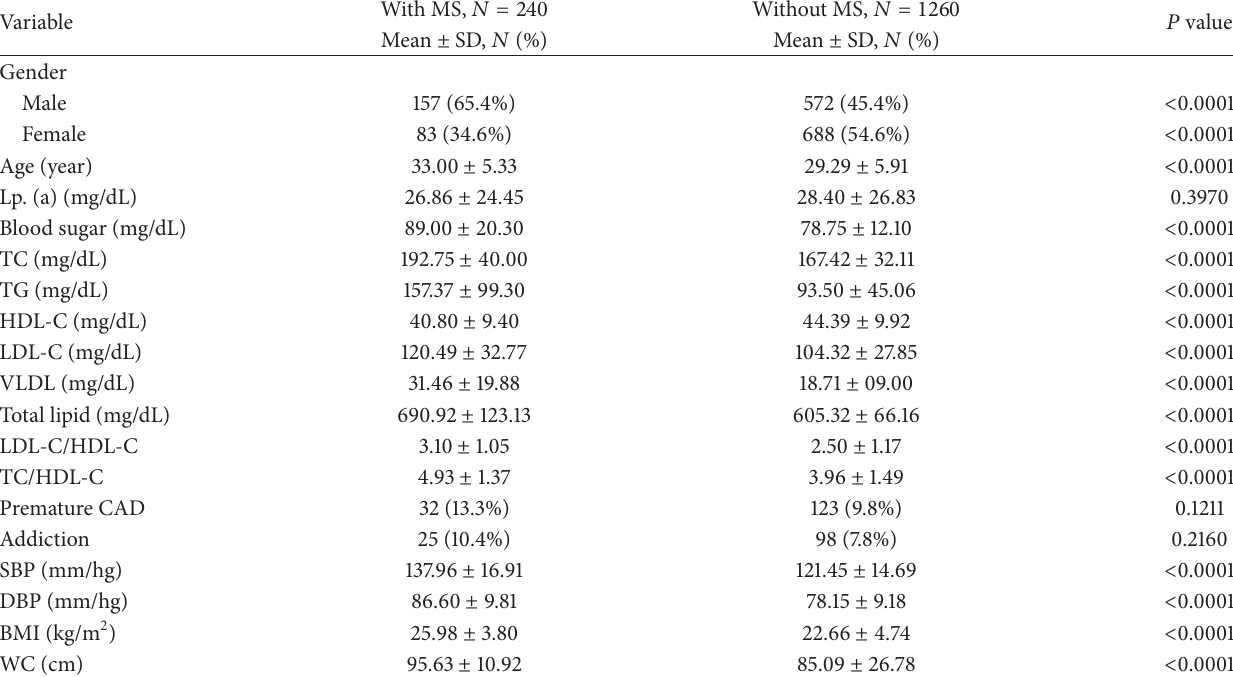
Table 2: Profile comparison of population with and without metabolic